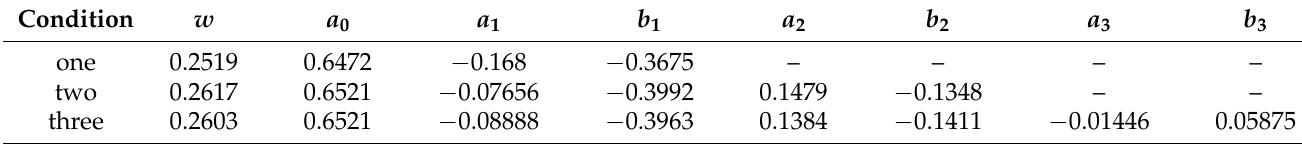
Table 5. Parameters of Fourier Series Approximation for the upward data